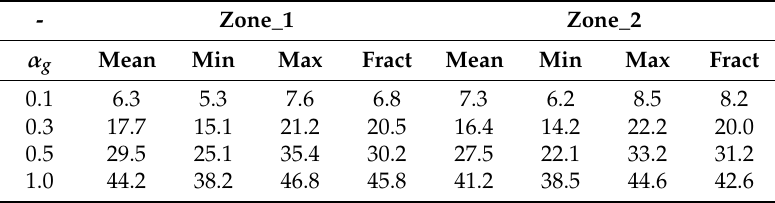
Table 6. Cross-aisle displacements at 15th level, with NLTH (in millimeters).